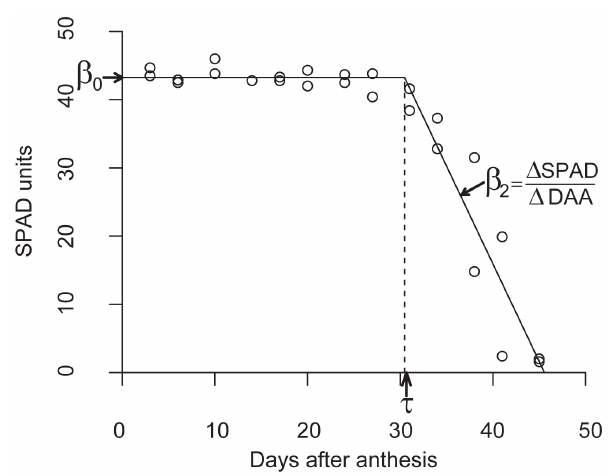
Figure 1. Example of model fit of senescence, variety ‘Va˚rpa¨rl’ (NGB6675). Parameters are indicated in the graph; b 0 is the intercept on the y-axis, t is the breakpoint on the x-axis and b 2 is the slope of the right